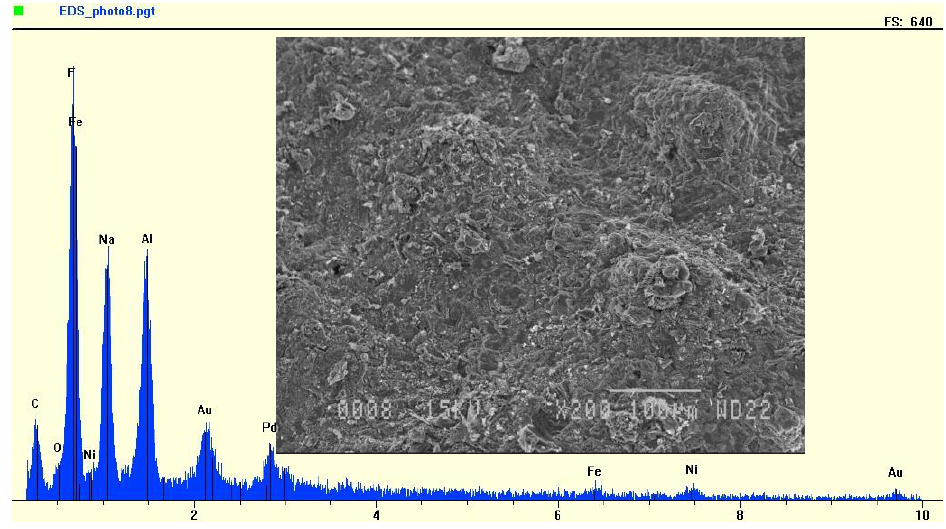
Figure 10. Typical results of SEM/EDS analysis of the dust containing region of Figure 1 (Sample B).